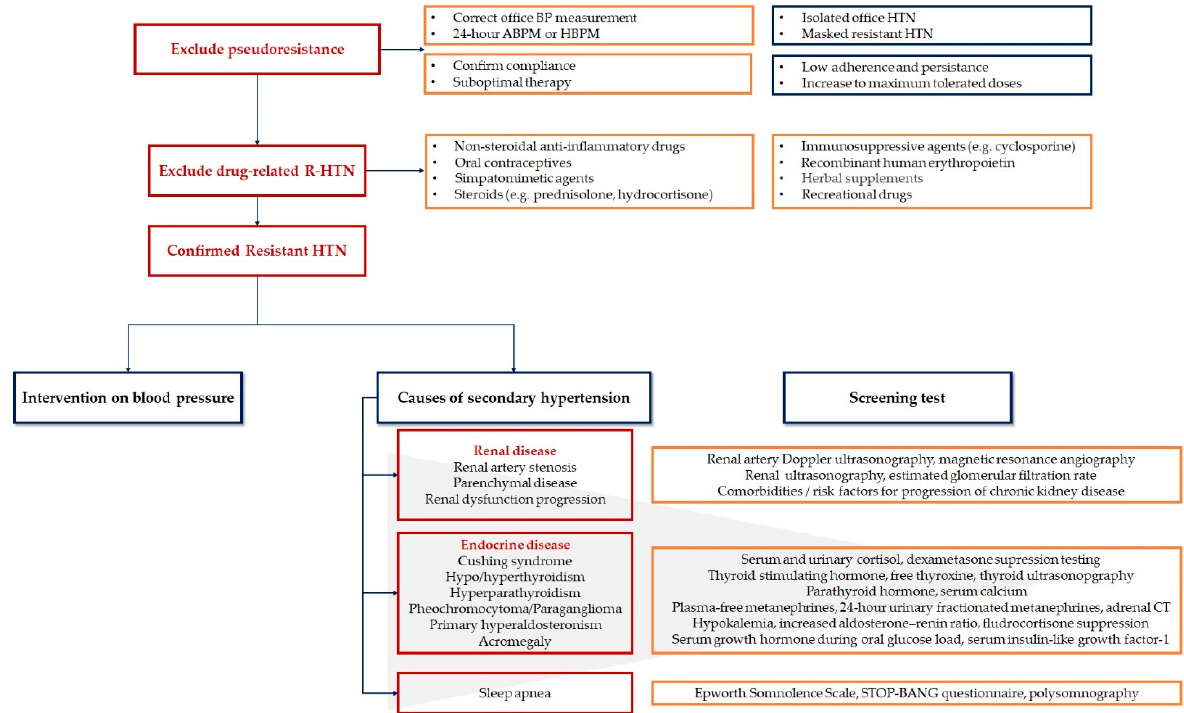
Figure 2. Diagnostic approach of resistant hypertension. ABPM: ambulatory blood pressure monitoring; CT: computed tomography; HBPM: home blood pressure monitoring; HTN: hypertension; R-HTN: resistant hypertension. Created based on information from literature [4,20,21].